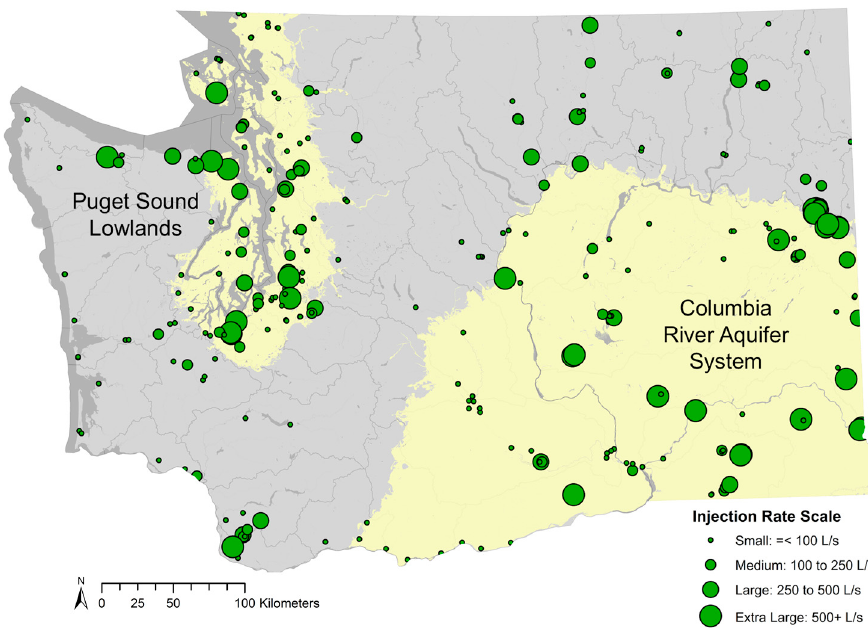
Figure 10. Results of potential injection capacity per well.